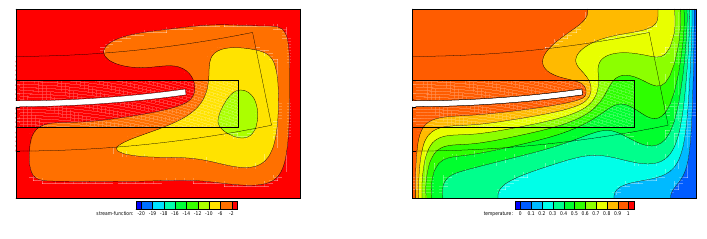
Figure 13. Stream function and Temperature for Ra = 10 5 and ρ = 6 . 5 .